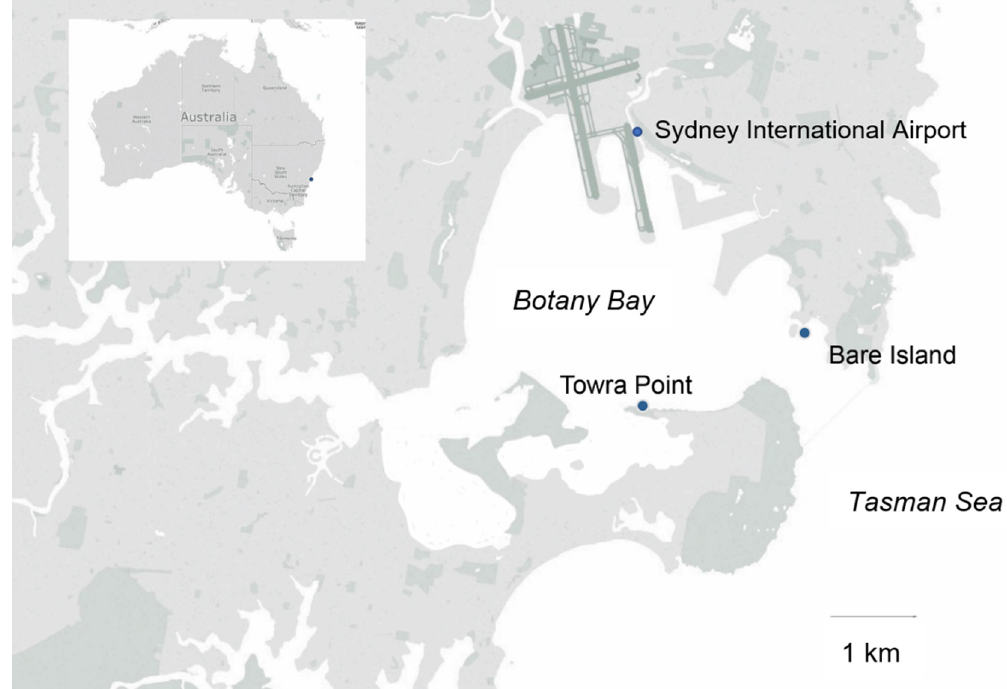
Figure 1. Map of Botany Bay in southeast Australia, highlighting the two sampling points used for the Marine Microbes project, Bare Island and Towra Point.